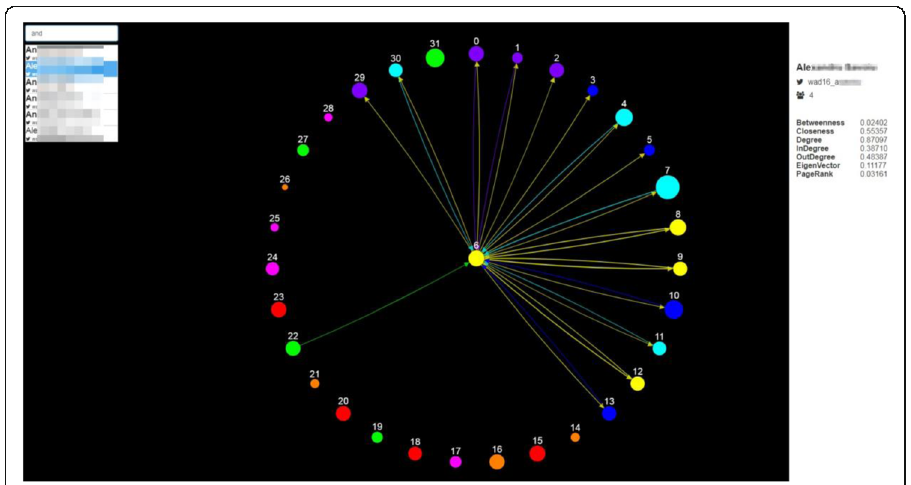
Fig. 2 StudentViz Main view - Focus-circular layout is employed. Nodes ’ diameters are proportional to their PageRank , while their colors depict affiliation to a specific team. Through this figure an instructor can observe the way in which a particular student, positioned in the center, relates to all the others. Also, in the right panel, the name, Twitter handle, team ID and several SNA metric values can be seen for the learner in case (please note that identifiable information is blurred in the screenshot, in order to preserve students ’ anonymity). This figure supports VN3, as well as P2 and